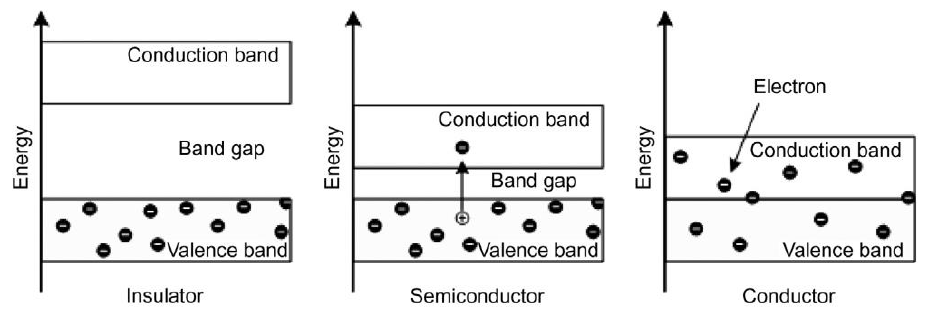
Figure 1. Band gap energy for different type of materials